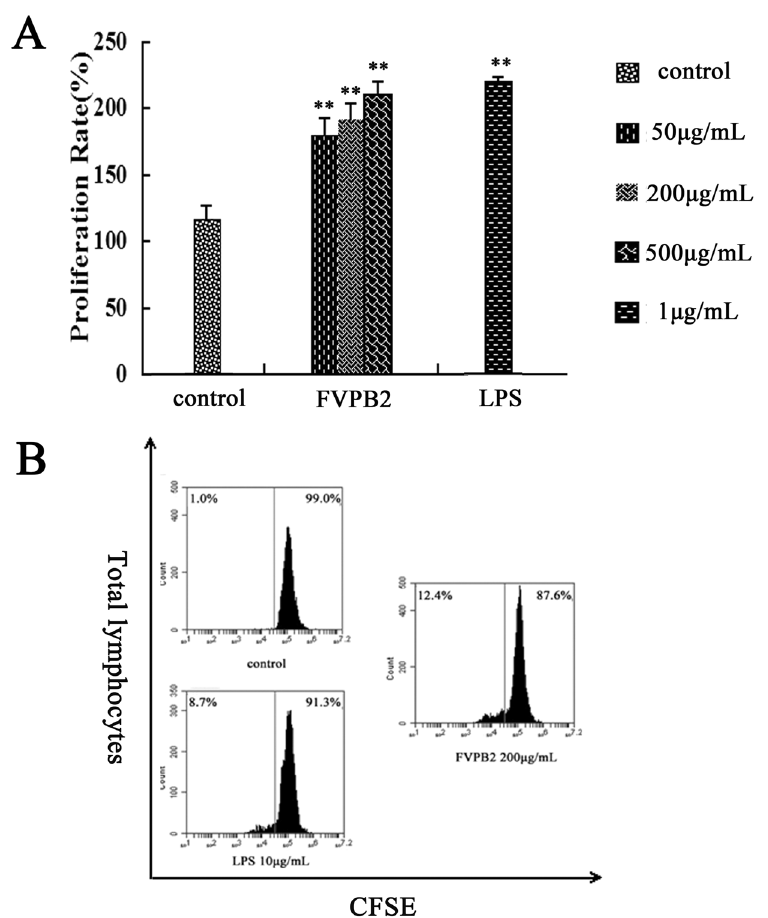
Figure 3. Proliferation of mouse spleen lymphocytes were stimulated by FVPB2. ( A ) Cells were treated by FVPB2 at the indicated concentration for 72 h ( * P < 0.05 or ** P < 0.01, vs. control); ( B ) After stimulation by 200 μ g/mL FVPB2 for 48 hours, analysis of lymphocytes was performed by FACS. Phosphate-buffered saline (PBS) and medium containing 10 μ g/mL LPS served as the negative and positive controls